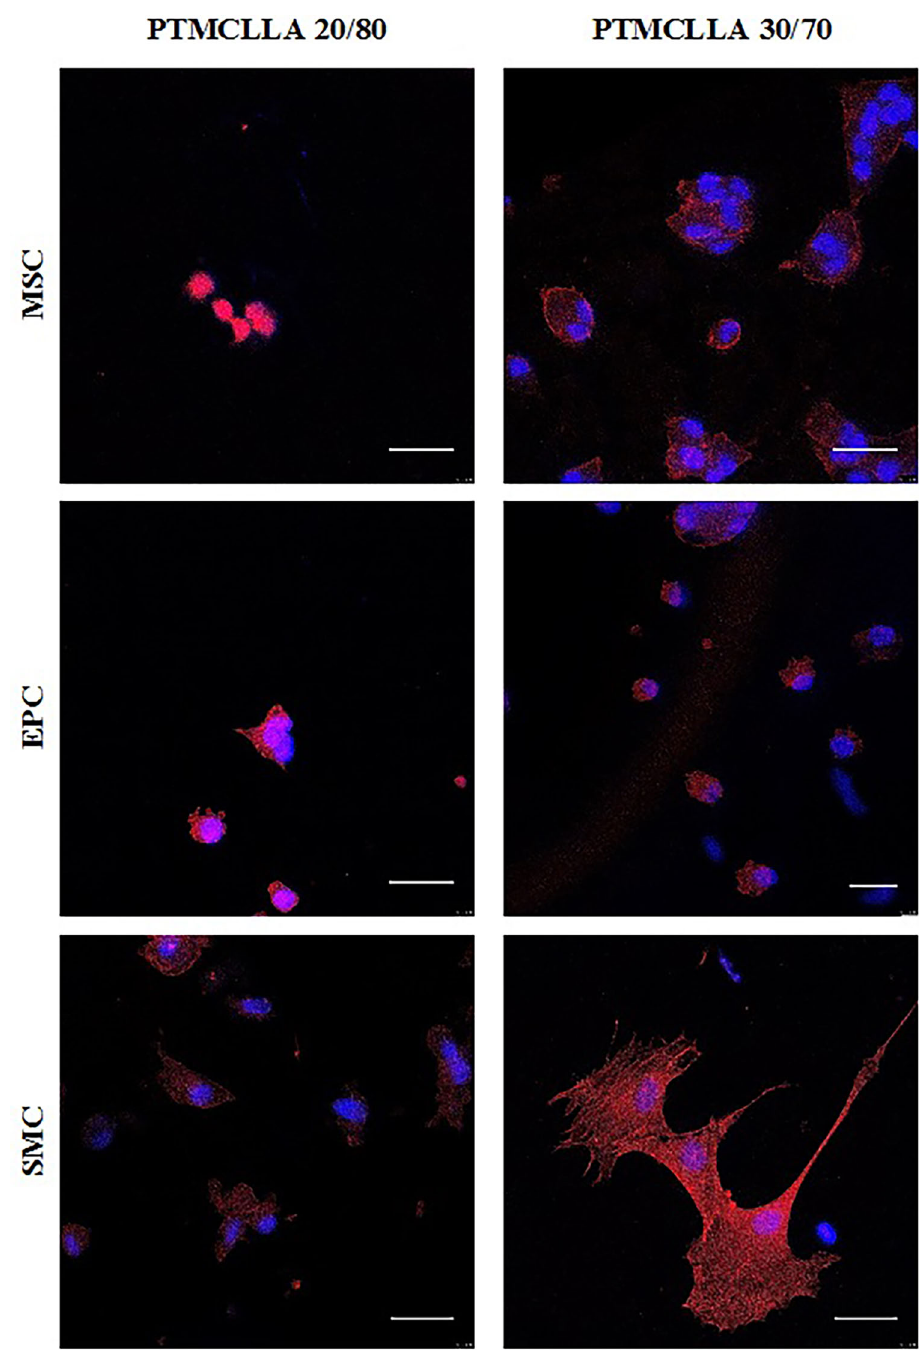
Figure 5. Confocal images of mesenchymal stem cells (MSCs), endothelial progenitor cells (EPCs), and smooth muscle cells (SMCs) cultivated on the poly(trimethylene carbonate- co -L-lactide) (PTMCLLA) 20/80 and 30/70 scaffolds for 24 h. The cells were stained with DAPI for nuclei (blue) and rhodamine-phalloidin for cytoskeleton (red). Original magni fi cation (cid:1) 63, scale bar 30 m